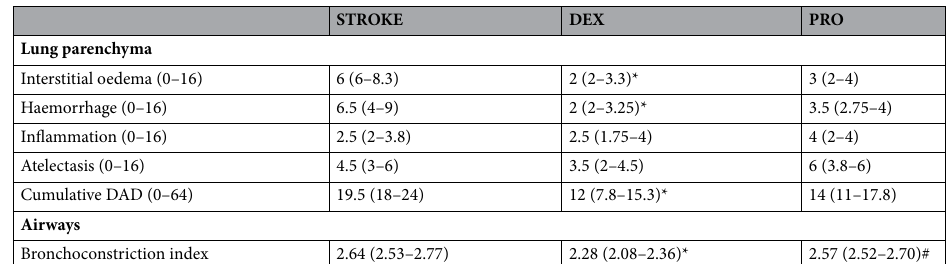
Table 1. Diffuse alveolar damage score and bronchoconstriction index. All animals were submitted to focal ischemic stroke. 24-h later, they were randomly assigned, by sealed envelopes, to (1) Group STROKE; (2) Group DEX; and (3) Group PRO. After 1-h of anesthetic infusion, lungs were removed for histology analysis. Cumulative DAD score representing injury from interstitial oedema, haemorrhage, inflammation and atelectasis. STROKE, animals submitted to stroke without dexmedetomidine or propofol infusion; DEX, animals submitted to stroke and submitted to dexmedetomidine; PRO, animals submitted to stroke and submitted to propofol. No difference was observed between PRO versus STROKE ( p = 0.177) and PRO versus DEX ( p = 0.404) in relation to cumulative DAD score. No difference was observed between PRO versus STROKE ( p = 0.999) in relation to bronchoconstriction index. Values are given as medians (interquartile ranges) of 5 animals in the STROKE group and 10 animals in the DEX and PRO groups. Comparisons were done by Kruskal–Wallis test followed by Dunn’s multiple comparisons test ( P < 0.05). vs *STROKE,